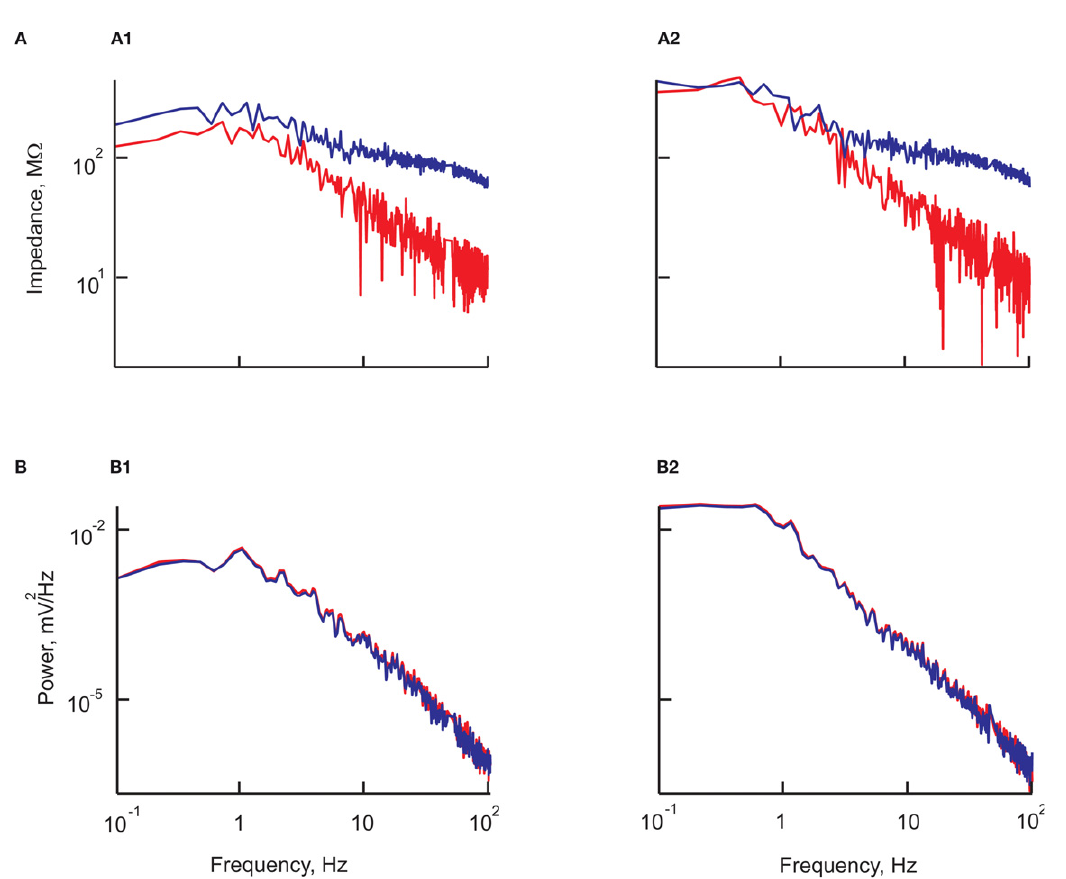
Figure 2 | The similarity in voltage noise spectra in soma and dendrites is inconsistent with the difference in corresponding input impedance. Impedance (A1,A2) and noise spectra (B1,B2) calculated at the soma (red) and the dendrite (blue) on a log-log scale. Left hand side panels (A1,B1) are meas- ured at the resting potential and right hand side panels (A2,B2) are measured for a depolarization of 9 mV. The impedance was estimated from the average response to 20 consecutive ZAP current injections. Note the difference in slope between soma and dendrite. The power spectra were calculated from 2 min long continuous recording after clipping the spikes. Note the similarity in the power spectra of the voltage noise at the two recording sites. All data were obtained from the same